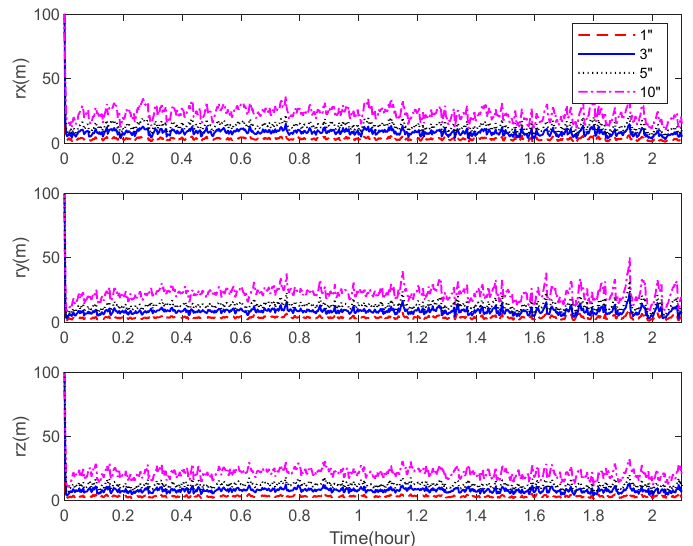
Figure 12. CRLB for the position estimation with different accelerometer noise levels.